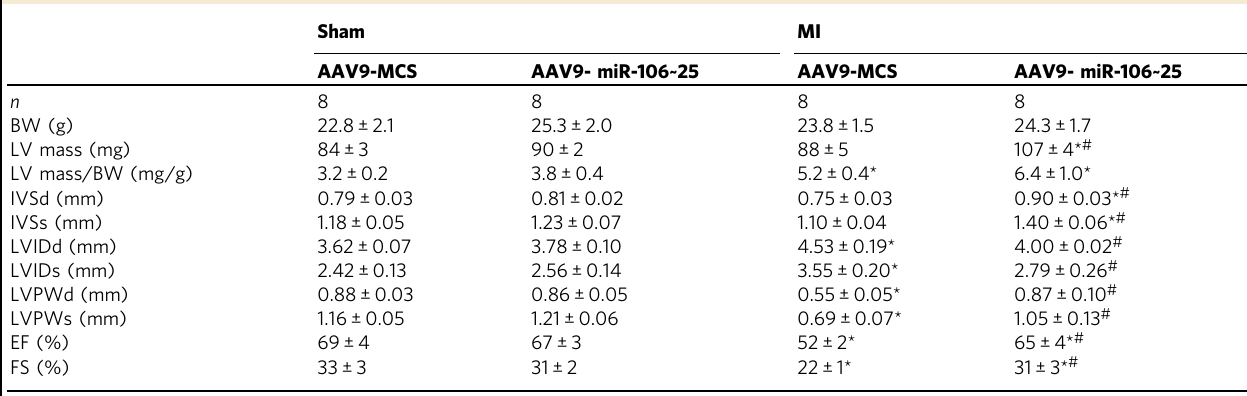
Data are expressed as means±SEM. BW body weight, LV left ventricular, IVSd interventricular septal thickness at end-diastole, IVSs interventricular septal thickness at end-systole, LVIDd left ventricular internal dimension at end-diastole, LVIDs leftventricularinternaldimensionatend-systole, LVPwd leftventricularposteriorwallthicknessatend-diastole, LVPws leftventricularposteriorwallthicknessatend-systole, EF ejectionfraction, FS fractional shortening, E/A Doppler E/A ratio. *Indicates P <0.05 vs sham group subjected to treatment with a control antagomir. # Indicates P <0.05 vs experimental